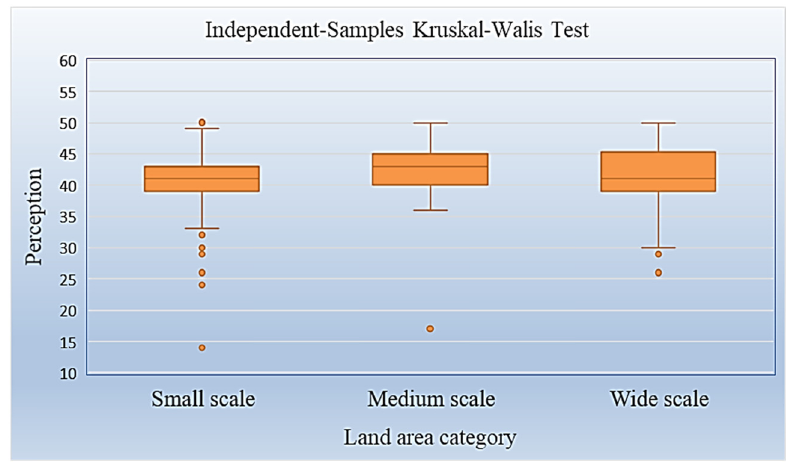
Figure 3: Box plot showing comparative distribution of perceptions on the potential of SFT based on the land scale.